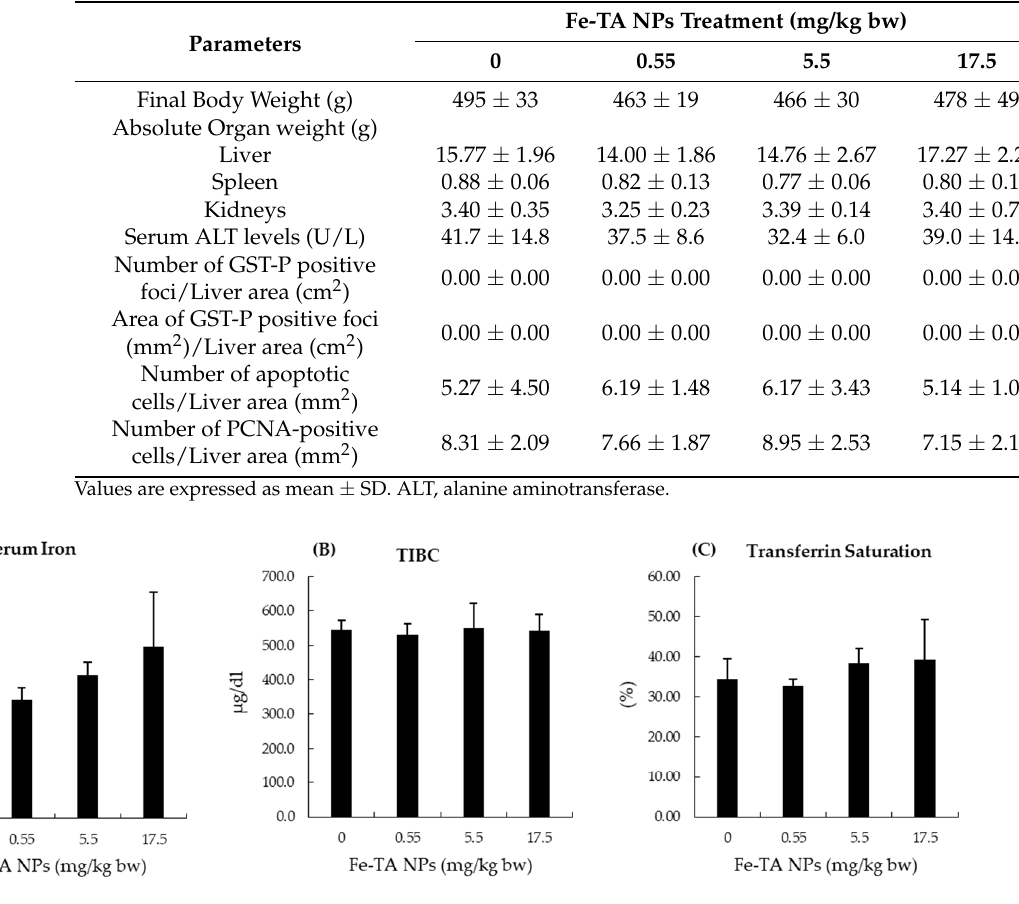
Table 5. Effect of iron (III)–tannic acid nanoparticles on general observation, serum ALT level, preneoplastic lesions formation, cellular apoptosis, and proliferation in rat livers.